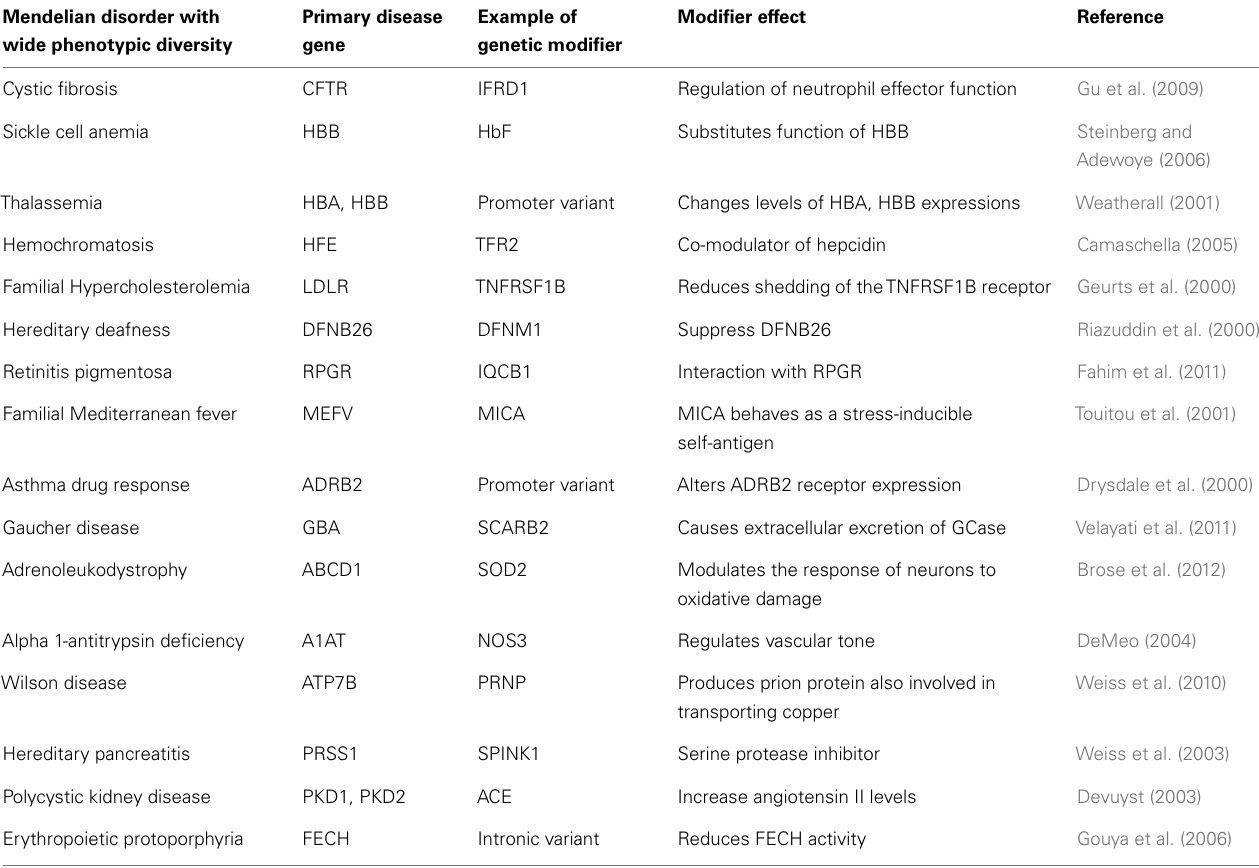
Table 1 | Mendelian disorders modified by gene